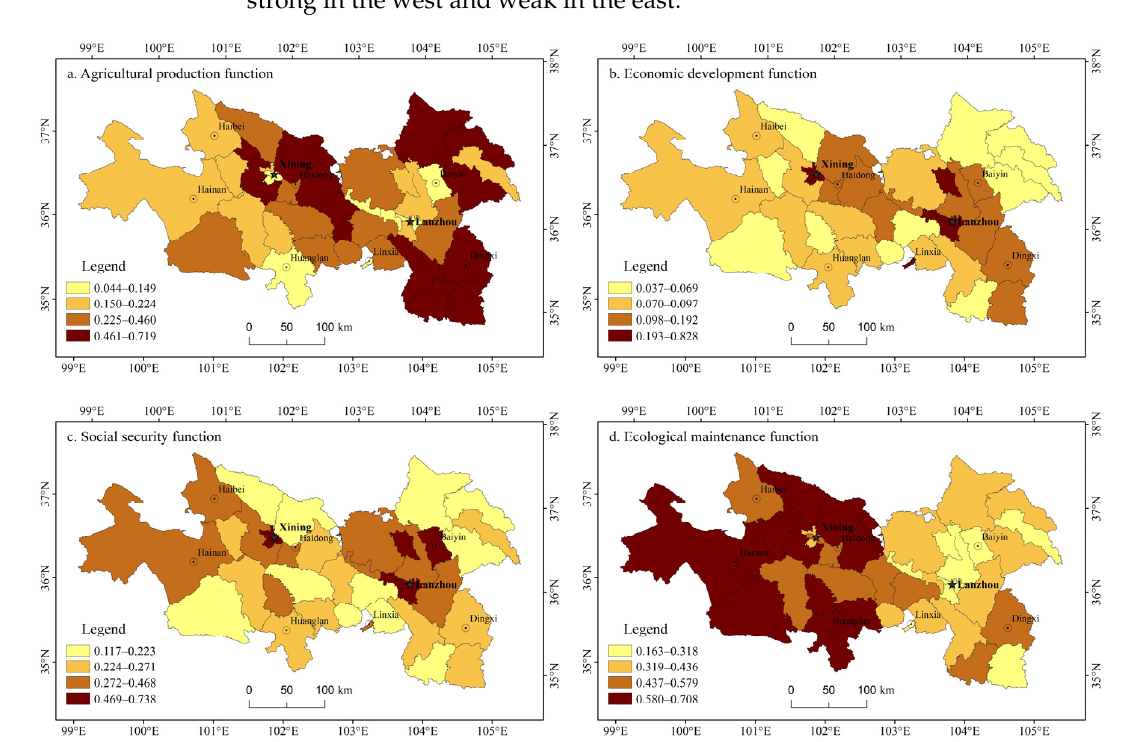
Figure 6. Spatial differentiation of LUFs.